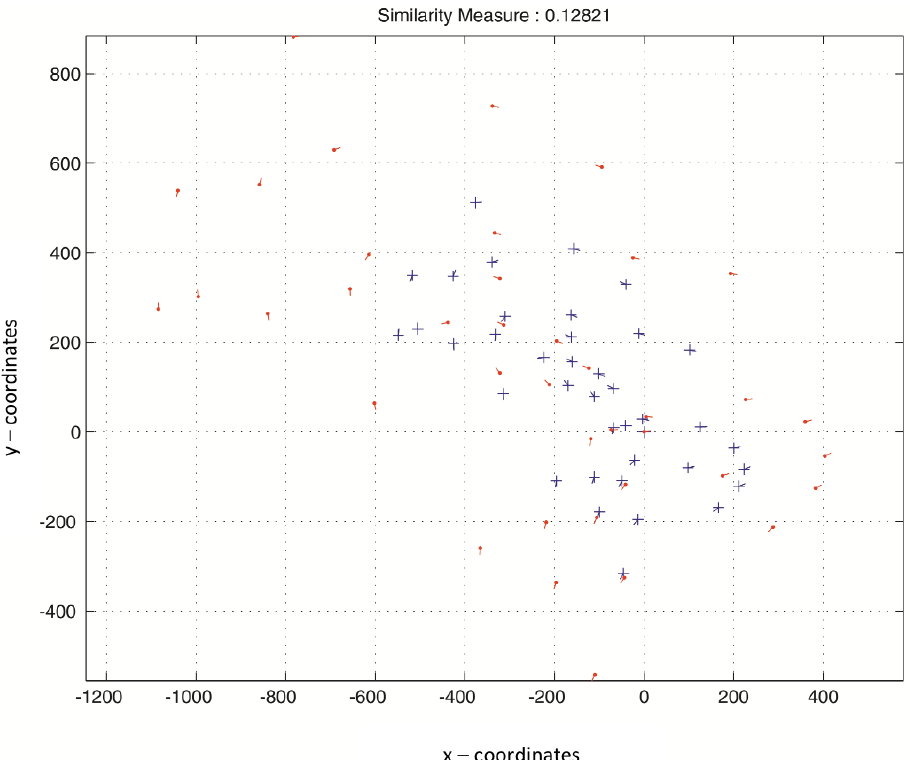
Figure 9. Matching score between two transformed fingerprint templates of the same user in two different databases.